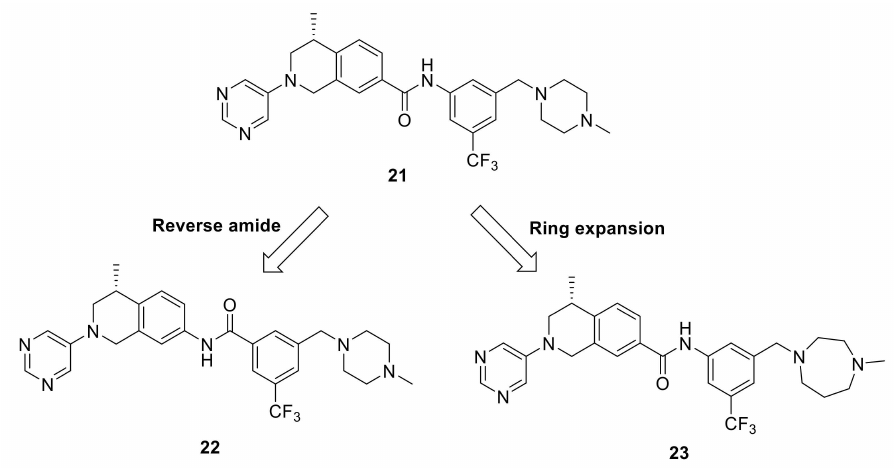
Figure 7. Drug design approaches and chemical structures of compounds 21 – 23 .